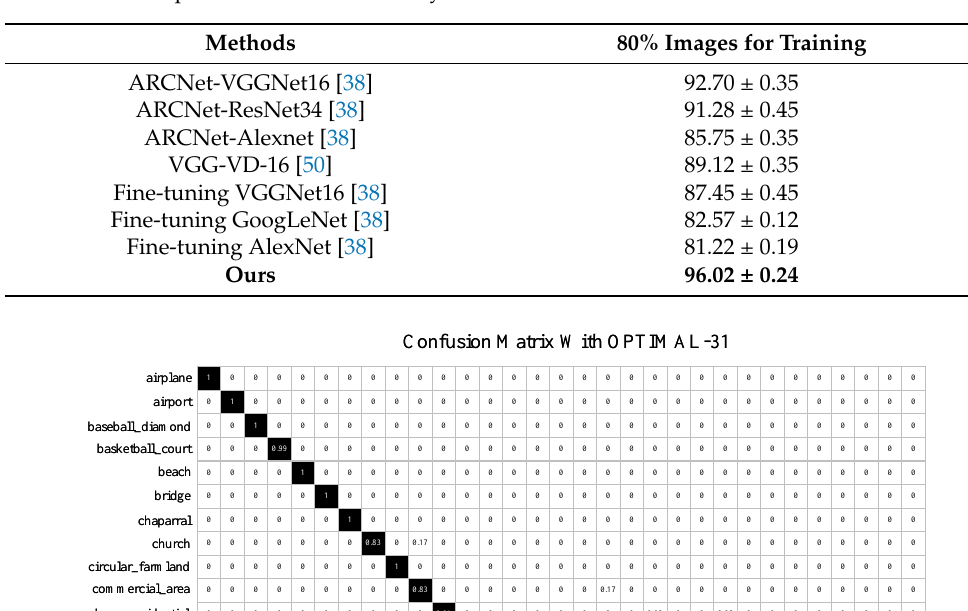
Table 5. The comparison of overall accuracy on the OPTIMAL-31 Dataset.